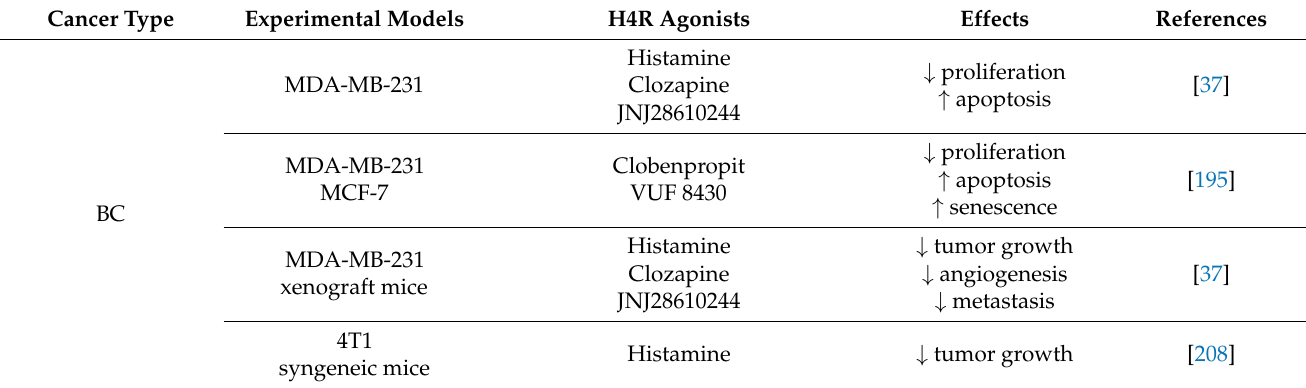
Table 3. In vitro and in vivo effects of H4R agonists on tumor progression in different cancer types. Cancer Type Experimental